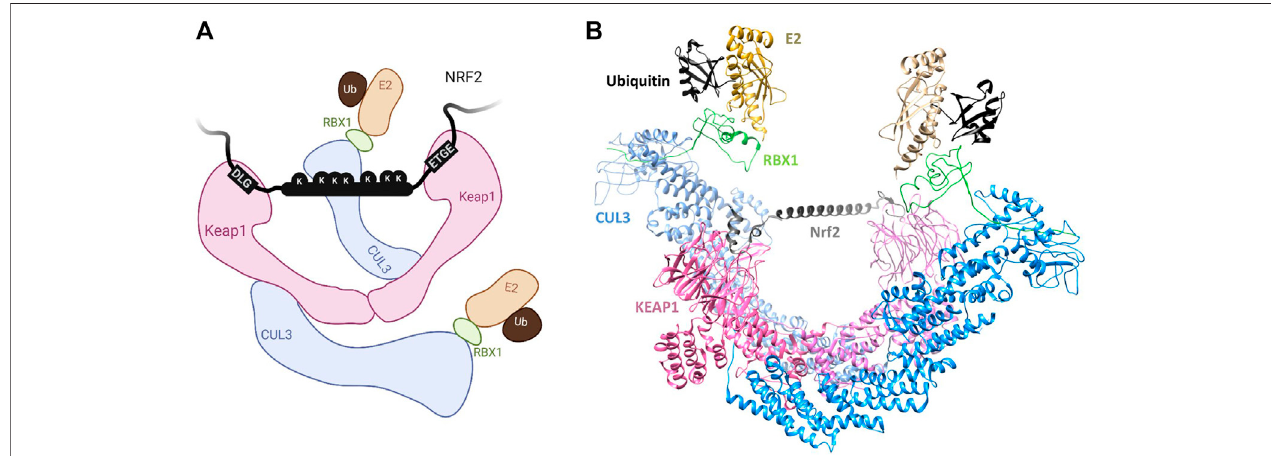
FIGURE 2 | (A) Schematic of the Keap1-Nrf2 interaction described in Section 2.1.1 . Created with BioRender.com. (B) Structural model of the full Keap1-CUL3- RBX1complexboundtoNrf2assembledasdescribedpreviously(structuralmodelkindlyprovidedbyA.Bullock,UniversityofOxford)(Canningetal.,2013).Apredicted helix in the Neh2 region of Nrf2 is modelled between the bound DLG and ETGE